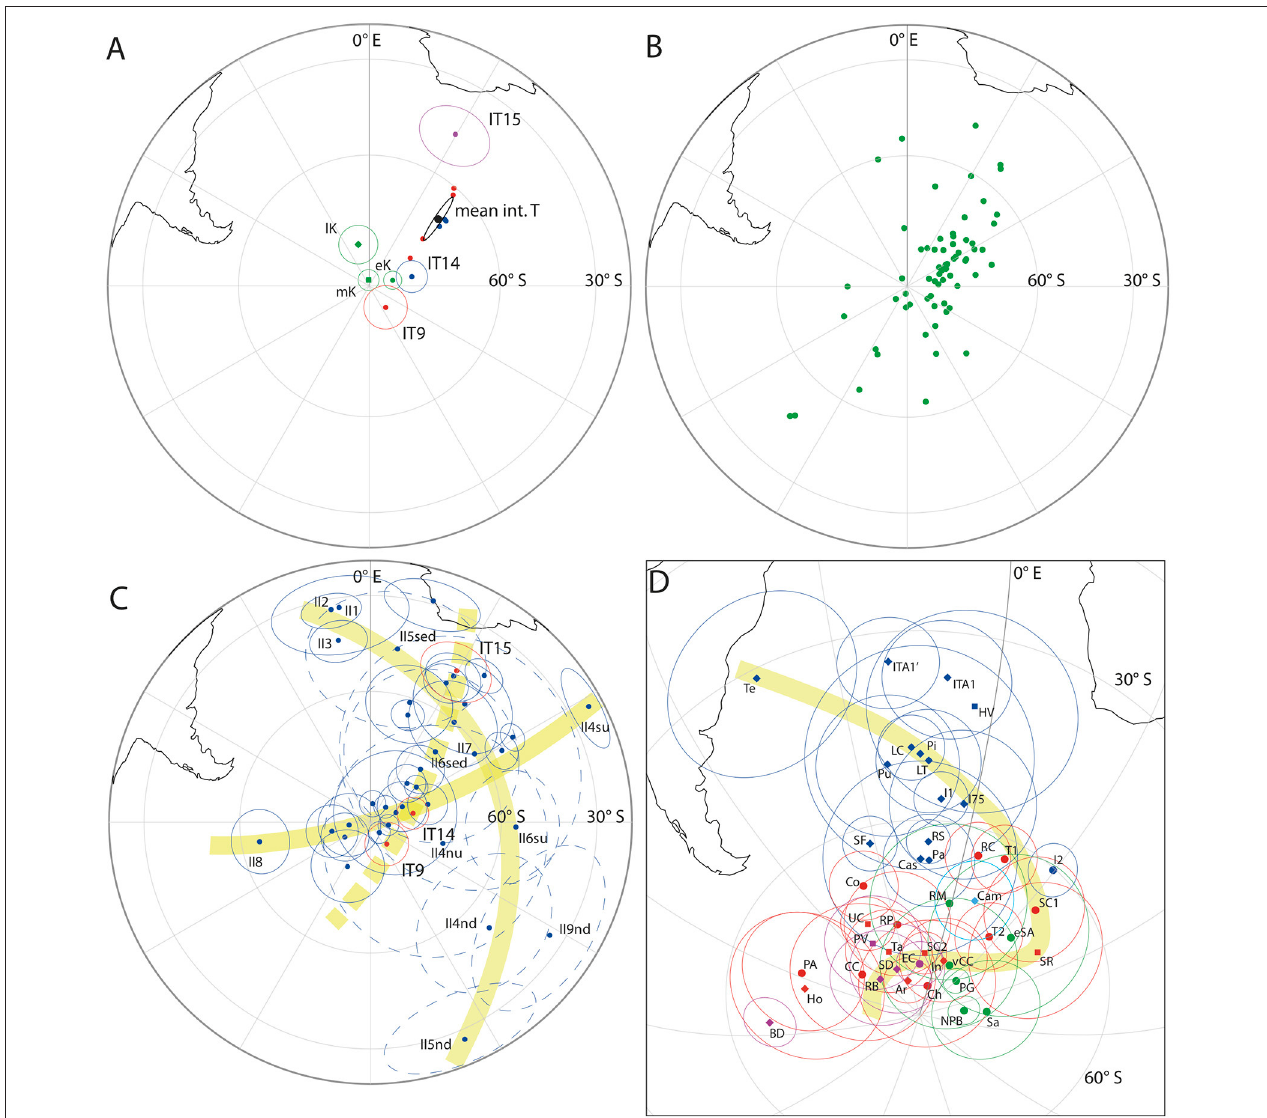
FIGURE 9 | Virtual Geomagnetic Poles (VGPs): (A) VGPs calculated from the high temperature component magnetizations isolated from the mafic sills at IT9 (red), IT14 (blue), and IT15 (purple), and from the mean low temperature component (black) isolated from IT9 and IT14. The reference early, mid- and late Cretaceous paleopoles (green) of Somoza and Zaffarana (2008) are plotted for reference; (B) VGPs from mafic intrusions and lava flows from the same study area reported by Ernesto et al. (1999); (C) VGPs derived from the sedimentary rocks of the Itararé Group (blue) and from the mafic sills (red). Dashed lines indicate VGPs with higher scatter ( α 95 > 15 ◦ ; k < 10). Highlighted in yellow are the approximate trends of the distributions of VGPs. Dashed-highlight is for the VGPs that follow the distribution of the igneous rock-derived VGPs, solid-highlights are for the N-S and E-W distributions of VGPs (see text and Table 1 ); (D) Paleopoles from relevant South American rock formations, for the Fm identifiers refer to Table 2 . Blue, red, purple, light blue and green are Carboniferous, Permian, Triassic, Jurassic, and Cretaceous data, respectively. For each geologic period, the circles, squares and diamonds are for early, mid- and late, respectively. Highlighted in yellow is the problematic loop in the classic APWP as reported by Tomezzoli et al. (2013). See text for